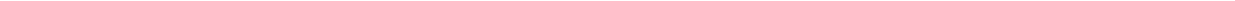
Figure 1 | Identification of an alternative splicing isoform of TEAD4 regulated by RBM4. ( a ) Schematics of human TEAD4 pre-mRNA and protein. The full-length TEAD4 contains 1–12 exons, including the DNA-binding domain in the N terminal, whereas exon 3 of TEAD4 can be skipped to generate a new isoform whose translation is started at exon 6 to produce a truncated TEAD4-S protein. TEAD4-S lacks an N-terminal DNA-binding domain, but still contains an intact C-terminal YAP-binding motif. ( b ) The localizations of TEAD4-FL and TEAD4-S were determined by immunofluorescence assay. Flag- tagged TEAD4-FL or TEAD4-S was transfected into cells. The immunofluorescence assay was performed with anti-Flag antibody to show the localizations of Flag-TEAD4. Scale bar, 25 m m. ( c ) Interaction of two TEAD4 isoforms with YAP protein as judged by co-IP experiment. The Flag-tagged TEAD4-FL or TEAD-S was co-transfected with HA-tagged YAP into 293T cells, and the binding of YAP was detected. ( d ) 293 cells expressing RBM4 on tetracycline induction were collected at different time points after induction to determine the expression levels of TEAD4-FL and TEAD4-S. ( e ) RBM4 regulates the splicing of TEAD4 in various cancer cells, including PANC1, HT1080, MDA-MB-231 and HepG2. The cells were stably transfected with RBM4 or vector control, and the splicing of TEAD4 was examined by RT–PCR. The representative gels were shown. ( f ) The schematic of TEAD4 pre-mRNA where the potential RBM4-binding site (CGGCCGG) in red. TEAD4 splicing reporters with the indicated mutations (mut1: CTTATA and mut2: GTAACG) were generated (upper panel). TEAD4 splicing reporters containing wild-type RBM4-binding site (lower-left panel) or mutations (lower-right panel) were co- expressed with RBM4 or vector control in 293T cells to assay for the splicing change of TEAD4. Representative gels from triplicate experiments were shown, with the mean ± s.d. of TEAD4-S% plotted below representative gels. ( g ) Binding of TEAD4 pre-mRNAs with RBM4 was examined by RNA- immunoprecipitation assay in cells exogenously expression FLAG-RBM4 or vector control. ( h ) 293 cells were co-transfected with Flag-RBM4 or vector control and the indicated mutant or wild-type (WT) TEAD4 reporters, and then immunoprecipitated with anti-Flag antibody. The co-precipitated RNAs were detected by